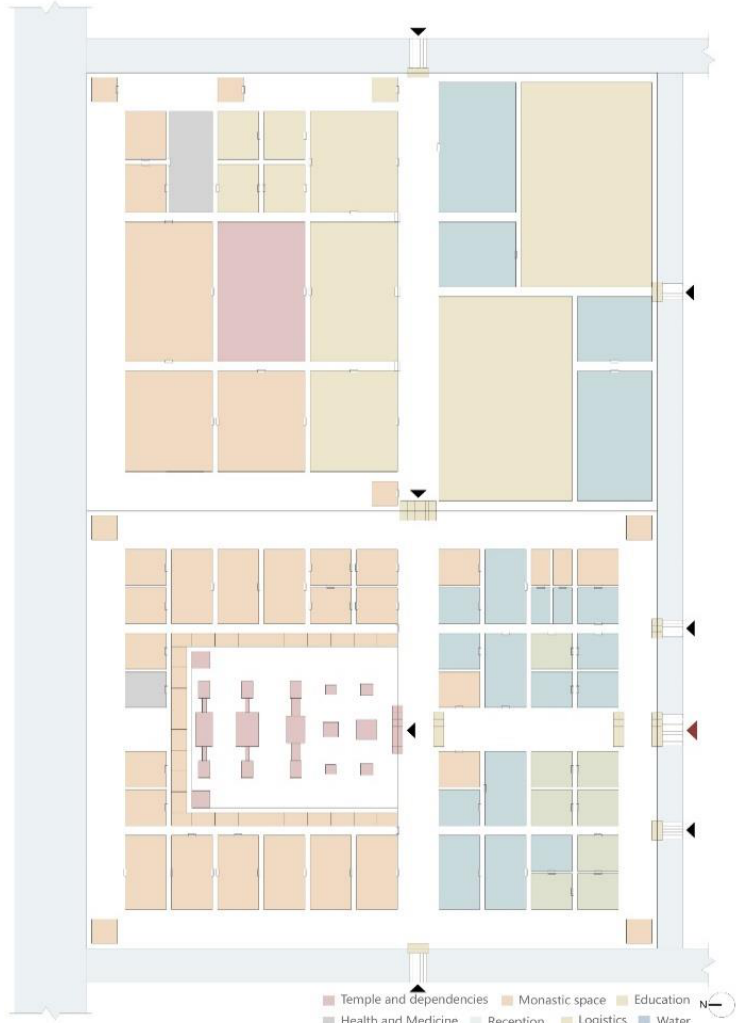
Figure 1. Illustrated Scripture of Jetavana Vihara of Sravasti in Central India (667).